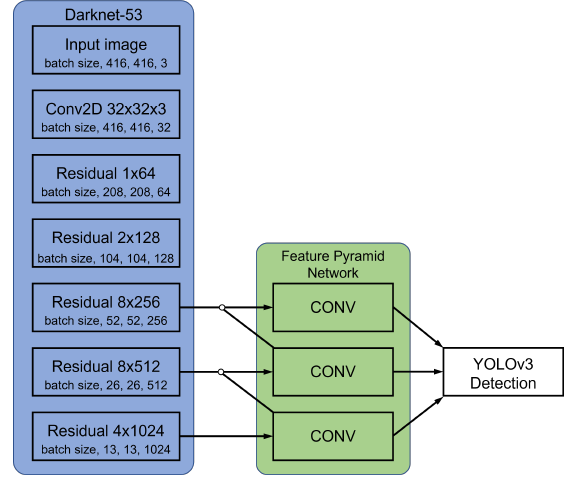
Figure 1. YOLOv3 Network Architecture